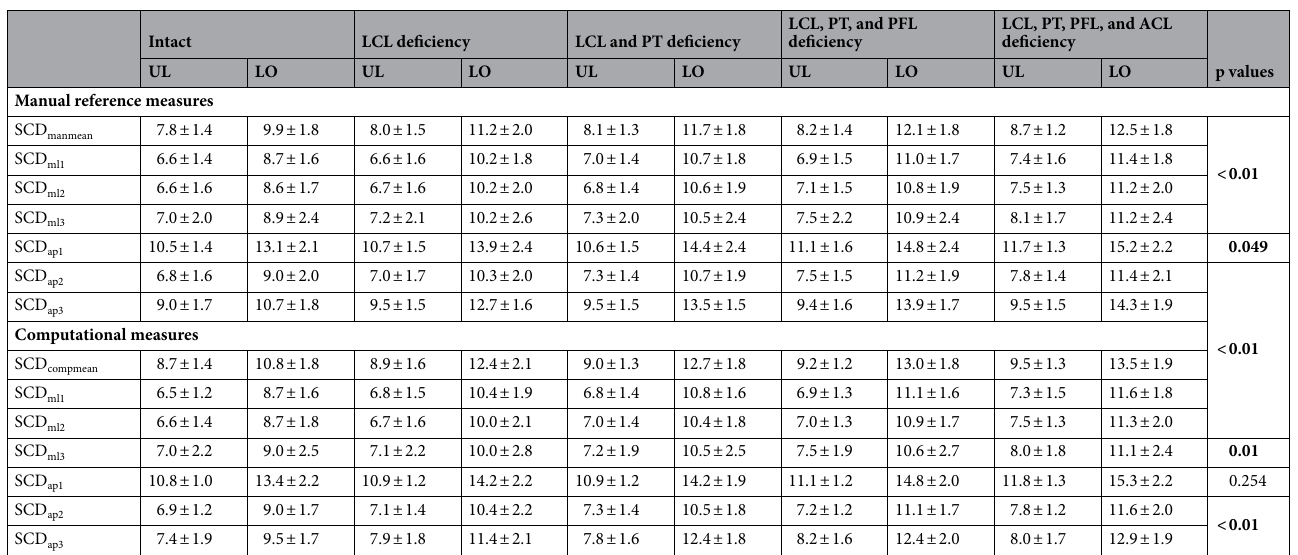
Table 1. Manually and computationally measured subchondral cortical distances (SCDs) as a function of loading configuration and joint condition. Manual reference measurements of SCDs were performed by two readers at six locations along the mediolateral (SCD ml ) and anteroposterior (SCD ap ) dimensions, respectively, and pooled data are indicated. Manually measured SCDs across the six locations were averaged (SCD manmean ). Computational measurements were performed using a grid of locations covering the entire lateral joint compartment, while, for comparison, SCD values for those grid points closest to the manual measurement locations (SCD ml , SCD ap ) are indicated. Computationally measured SCDs across all grid points of the entire lateral joint compartment were averaged, too (SCD compmean ). Data are given as means ± standard deviations. Configurations are unloaded (UL) and loaded to 147 N (LO), while conditions are sequential deficiencies of the lateral collateral ligament (LCL), popliteus tendon (PT), popliteofibular ligament (PFL), and anterior cruciate ligament (ACL). Statistical analysis of SCD values was based on repeated measures two-way ANOVA and significant differences are highlighted in bold type. p-values are reported for the comparison of all conditions and configurations. Select post-hoc details are provided in Supplementary Table